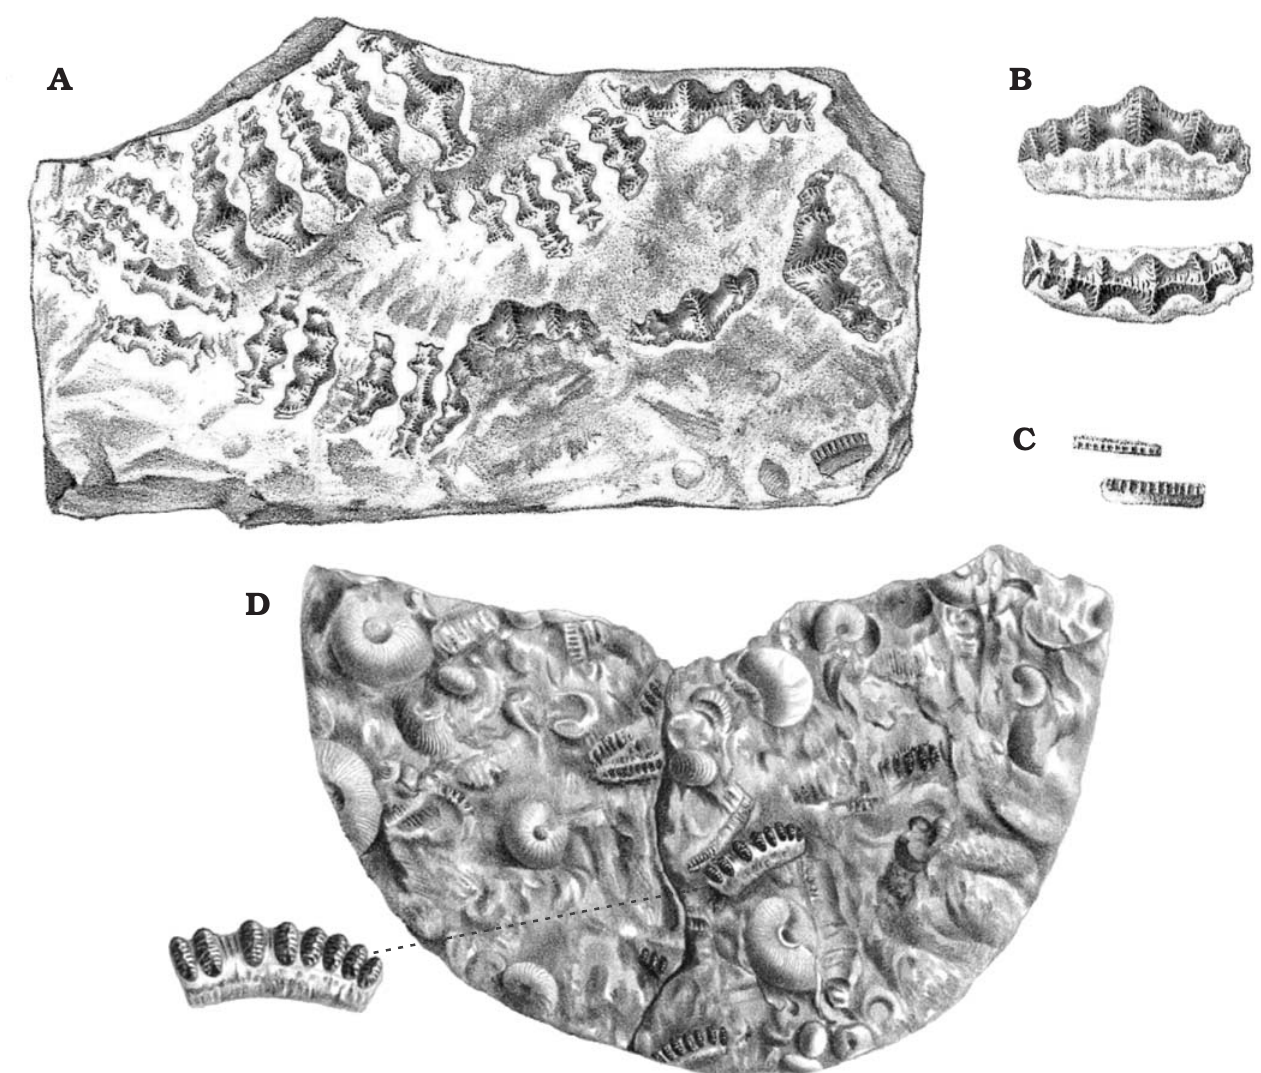
Fig. 7. Teeth of Campodus agassizianus De Koninck, 1844, from the Chokierian of Belgium, near Liège. A – C . Specimens whereabouts unknown, from Lohest (1884). D . Holotype (left part NHMUK P.28754, see Fig. 8 herein; right part whereabouts uncertain), from De Koninck (1844). Not to